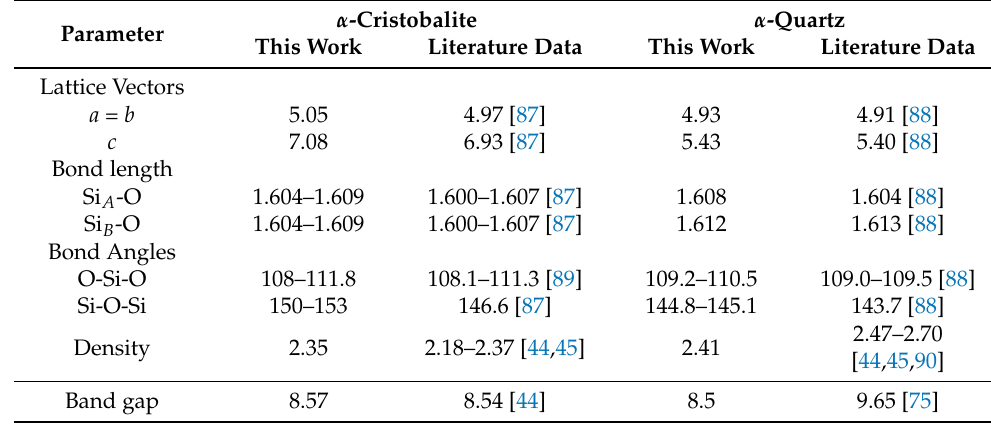
Table 1. The structural properties of α -cristobalite and α -quartz compared to the previous experimen- tal and theoretical literature. The geometric structure is also shown, with the band gap separated at the bottom of the table. All bond lengths and lattice vectors are in Å, all angles are in degrees ( ◦ ), the density is in g/cm 3 , and the band gap is in